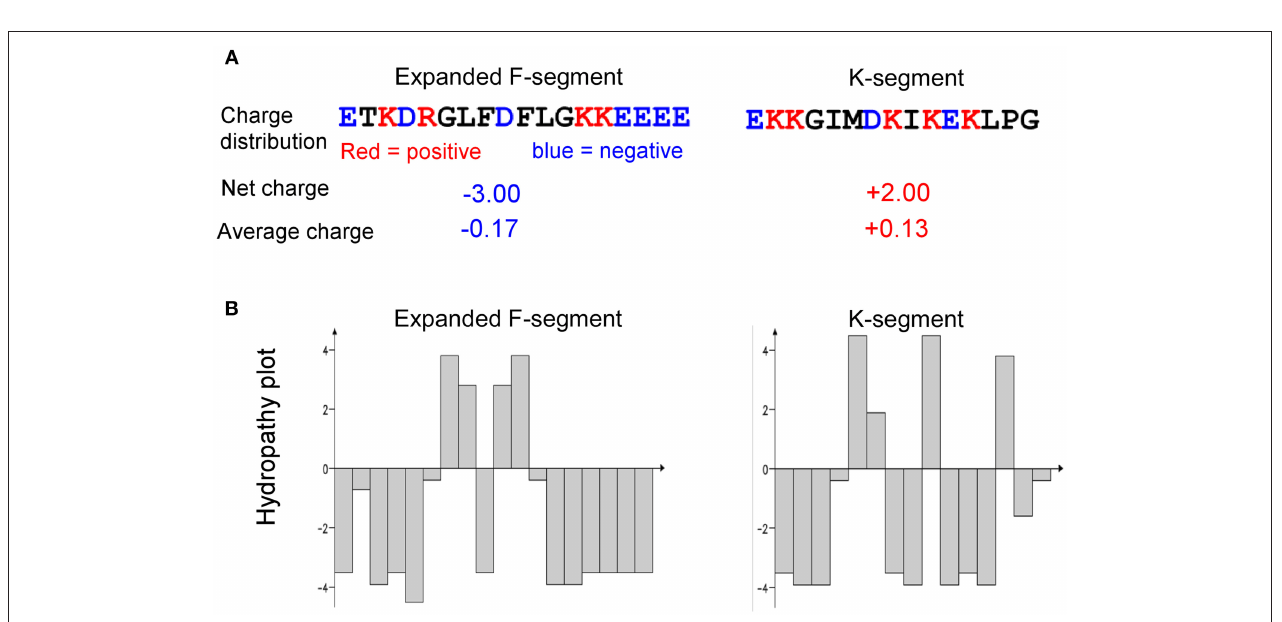
FIGURE 8 | Consensus amino acids of expanded F-segment in dehydrin protein hits from BLASTP search against rhododendron expanded F-segment containing RcDhn2. The sequence graphics in the upper panel was created using WebLogo program. Single letters are abbreviations for amino acids. The number after the letters in the lower panel indicates the occurrence of each amino acid residue at each position. “-” represents a gap in alignment. The most hydrophilic amino acids lysine (K), glutamate (E), aspirate (D) and arginine (R) are indicated by the star marks (*), and counted as K 3 E 5 D 2 R 1 .